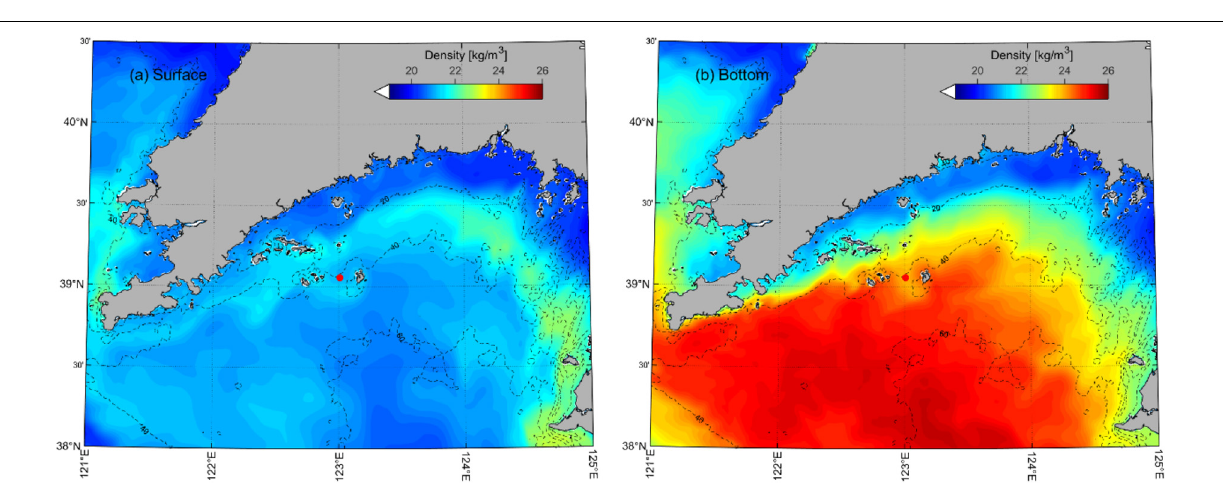
FIGURE 3 | (a) Surface and (b) bottom density (kg/m 3 ) computed from the numerical model results for July 2017. The dashed lines represent the isobath contours of 20, 40, and 60 m. The ADCP mooring site is shown with the red